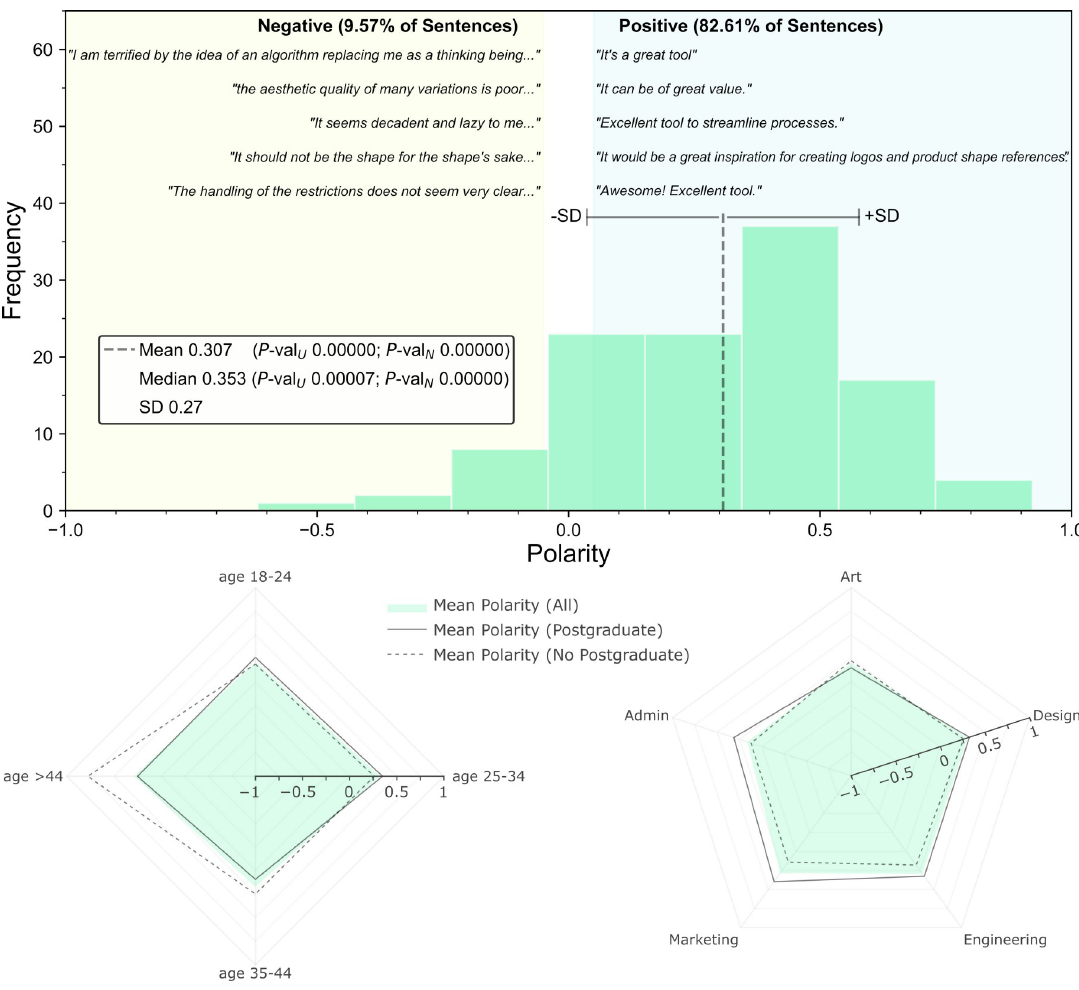
Fig 23. Polarity of the open feedback from the survey. It is displayed by frequency, age group, occupation, and Postgraduate